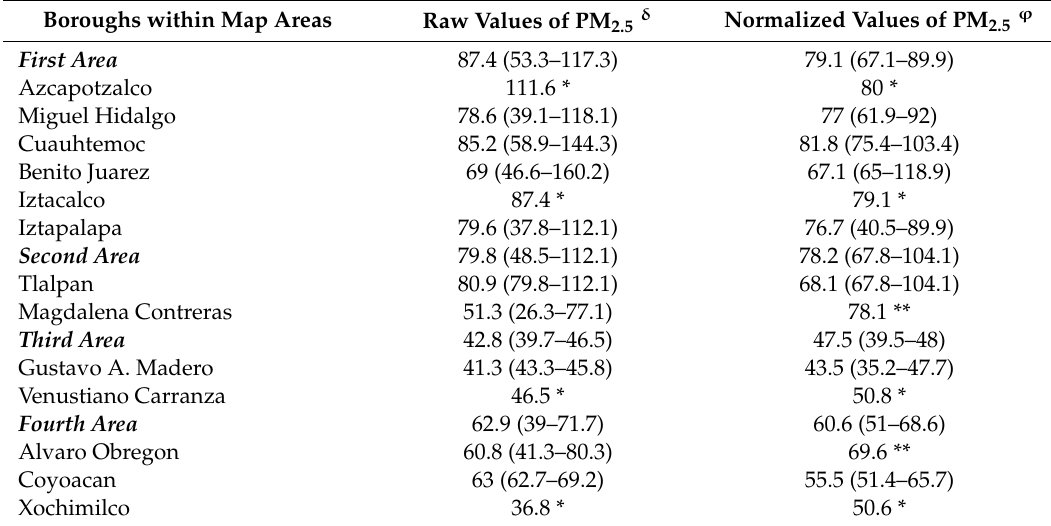
Table 1. Comparison of raw and normalized values of PM 2.5